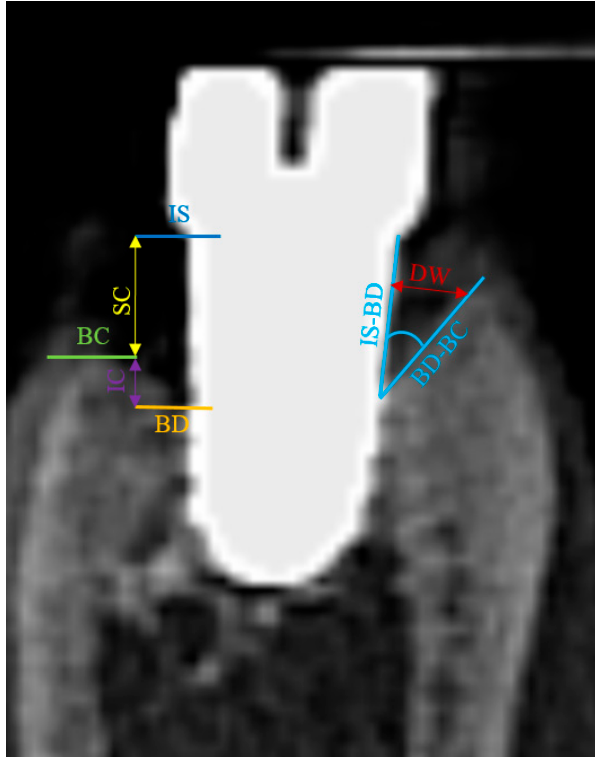
Figure 6. Landmarks identified in each sagittal image at all buccal, oral, mesial and distal aspects: IS (implant shoulder), the bottom of the bone defect (BD), the alveolar bone crest (BC) and the angle between segments IS-BD and BD-BC. CBCT implant #5 (original magnification ×8). between segments IS-BD and BD-BC. CBCT implant #5 (original magnification ×